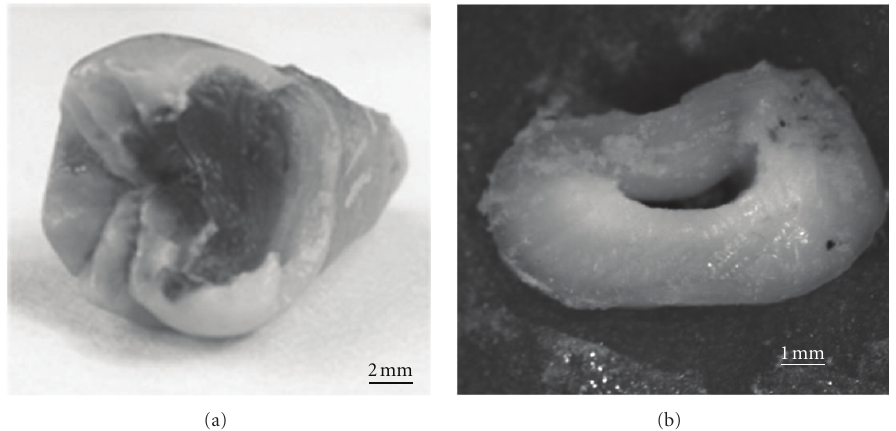
Figure 3: Stereomicroscope images of (a) tooth with carious lesion and (b) tail end of root canal.